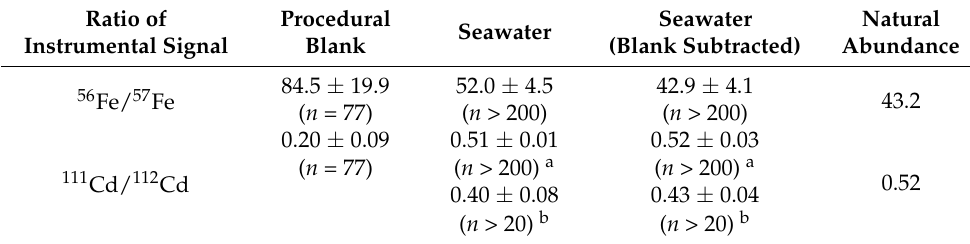
Table 7. Ratios of instrumental signals based on two masses measured in ICPMS. Ratio of Procedural Instrumental Signal